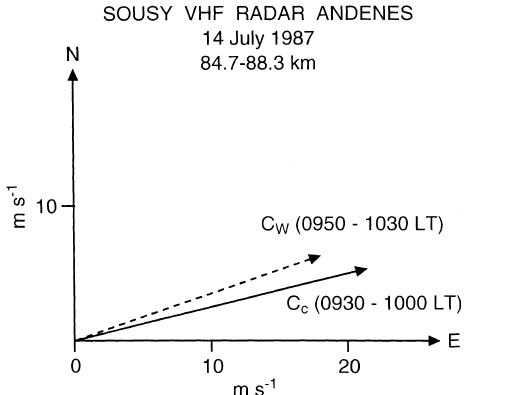
Fig. 10. Vector diagram of the phase trace velocities of the observed wave c w , and the turbulent cells c c